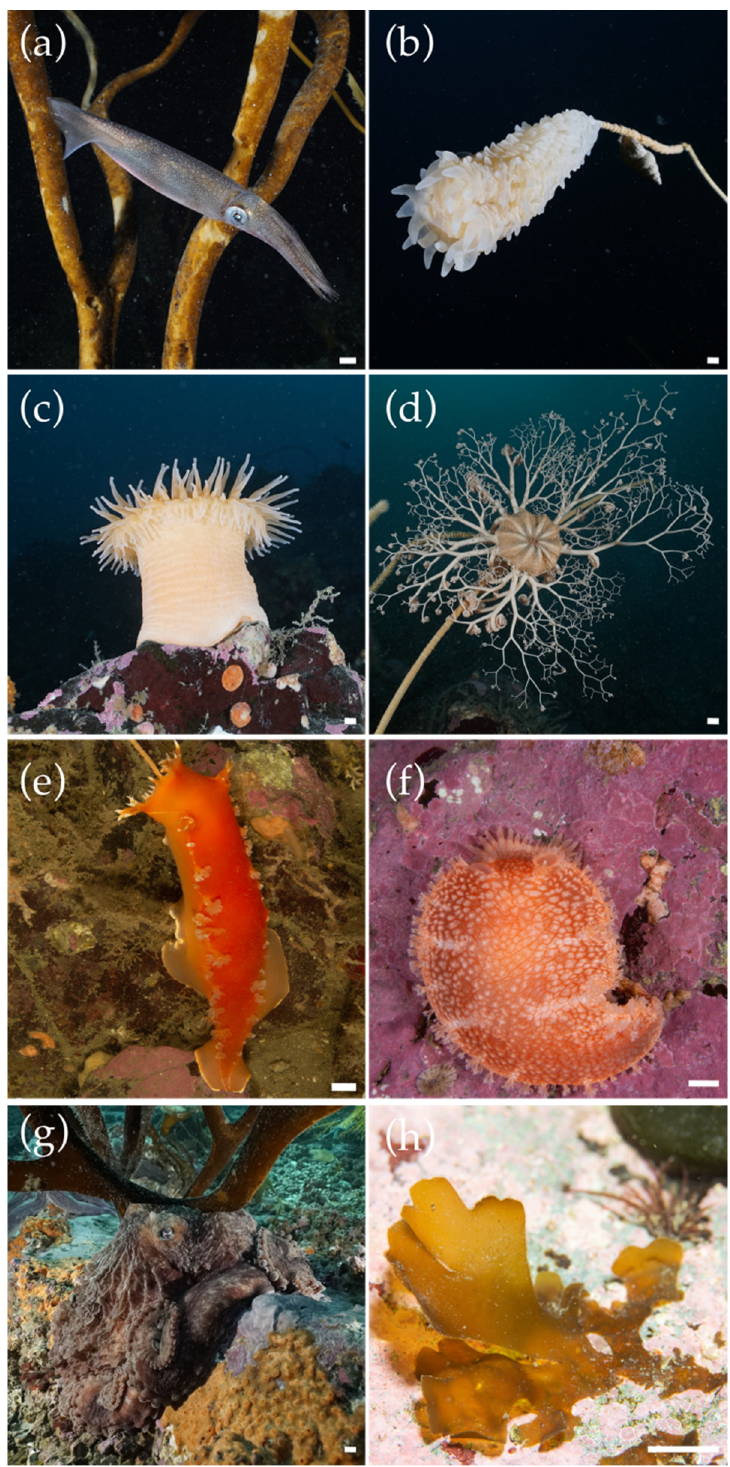
Figure 3. Some interesting species recorded in the field. ( a ) Doryteuthis gahi ; ( b ) Dactylanthus antarcticus ; ( c ) Actinostola sp.; ( d ) Gorgonocephalus chilensis ; ( e ) Tritonia odhneri ; ( f ) Tritonia vorax ; ( g ) Enteroctopus megalocyathus ; ( h ) Dictyota falklandica . The scale bars correspond to 1 cm. Rare species: Infrequent species (because of their low density or infrequent presence Pelagic/nocturnal species: In contrast with traditional surveys where the focus is in one particular environment) could be challenging to detect with traditional methods generally on benthic species, the roving diver method allows also registering pelagic such as transects or quadrats. As the roving diver survey commonly explores a broader species (e.g., jellyfish), occasional visitors (e.g., sea lions), and epibenthic species that area, the chances to find rare species increase. The possibility of freely exploring different